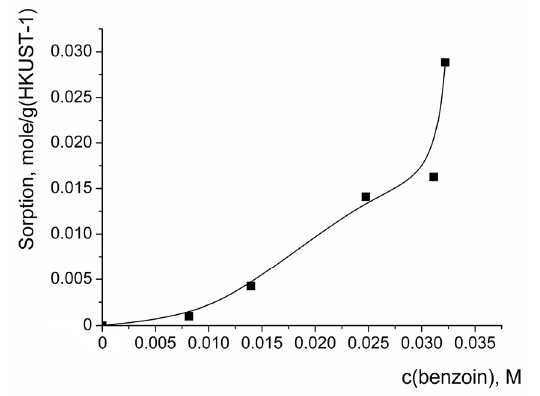
Figure 8. Isotherm of benzoin adsorption on HKUST-1 from solution in a mixture of acetonitrile and water (corresponding to solvent composition in the reaction mixture in the oxidation experiments, where water was added as a component of a 35% water solution of H 2 O 2 ). Solid line in the graph is to guide the eye. C(benzoin) is equilibrium concentration.